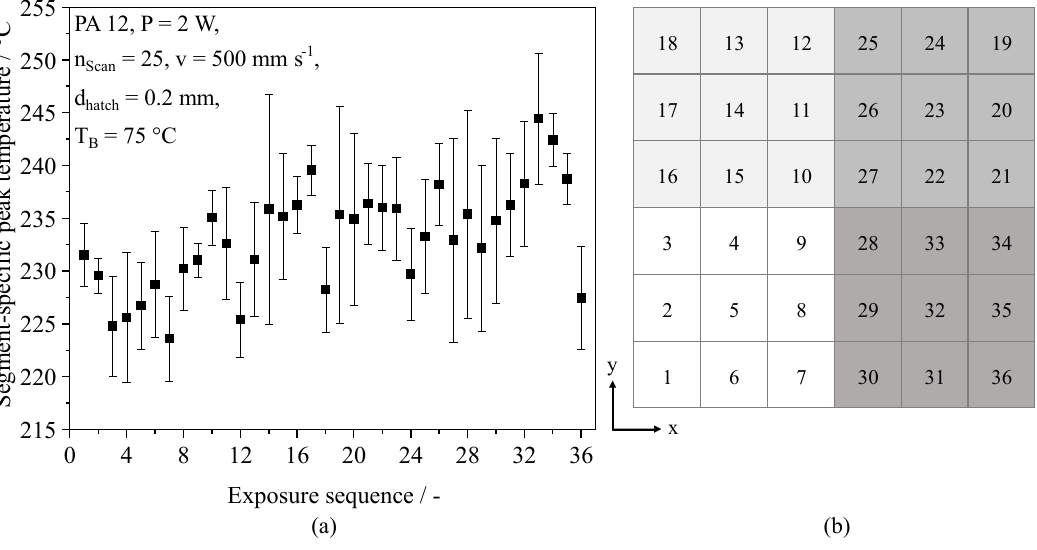
Figure 8. ( a ) Influence of the exposure sequence of a 10 × 10 mm 2 cross-section on resulting peak temperature values; ( b ) Spatial representation of the fractal exposure sequence of distinct segments.